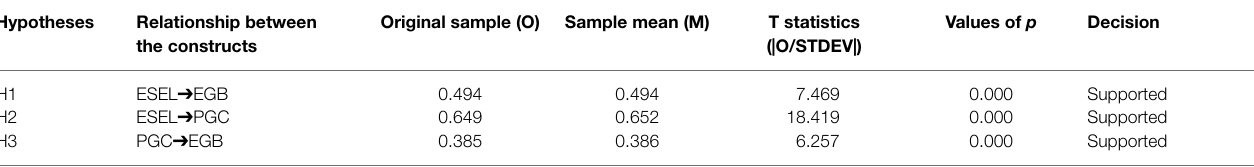
TABLE 8 | Structural model direct hypotheses